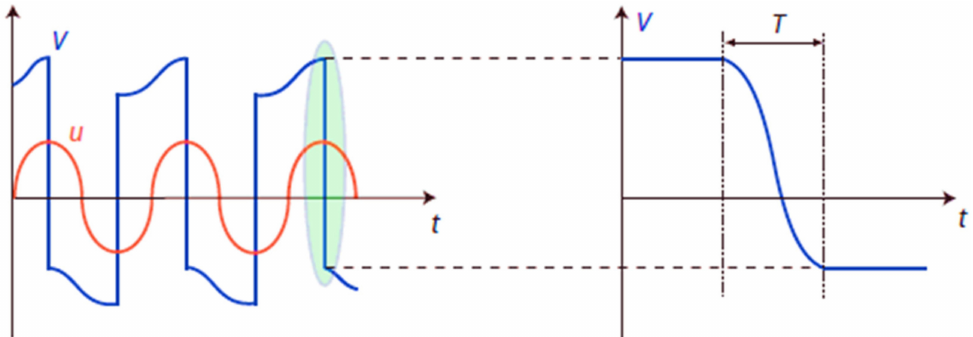
Figure 3. Periodic vibration (u) and voltage (V) waveforms for piezo